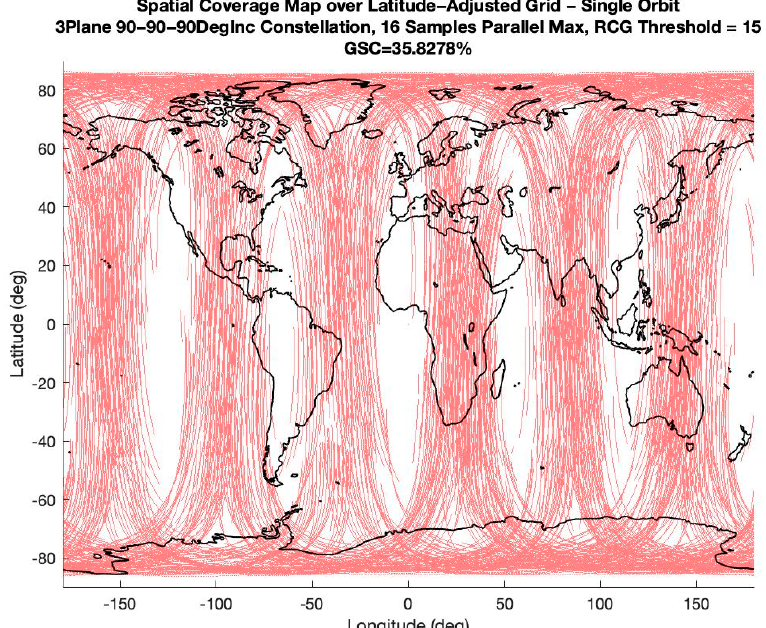
Figure 4. Single-Orbit Spatial Coverage for 3-Plane 90°-90°-90° constellation at 800 km, 16 parallel measurements per sampling, and operating with an RCG Threshold of 15. The 90° maximum plane inclination allows the constellation to achieve near 100% GSC after 24 h.